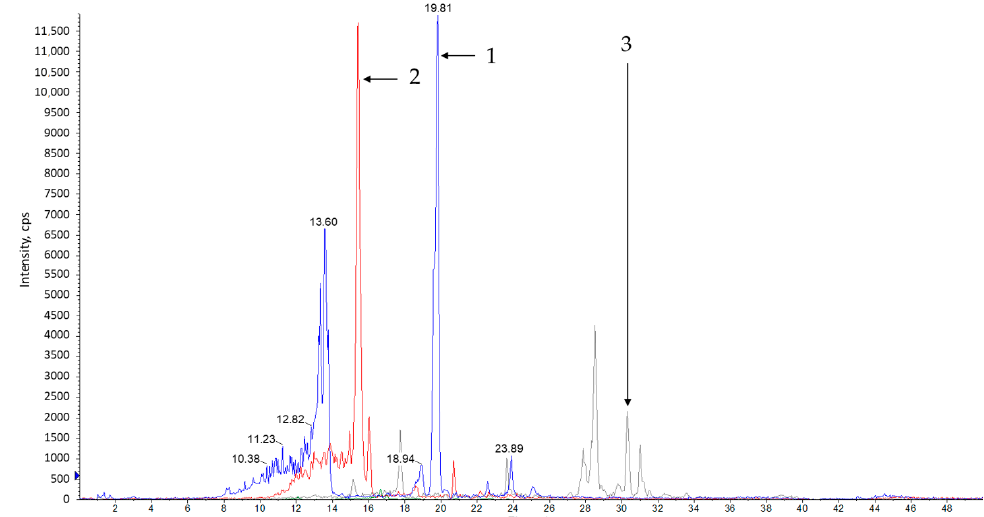
Figure 3. Example of a TIC chromatogram for extract of salvia leaves dried naturally. The chromatogram was obtained for the maximum absorbing wavelength at each time point; (1) p - coumaric acid (m/z = 162.8/119.1) and its derivatives; (2) ferulic acid (m/z = 192.8/134.0); (3) catechin (m/z = 289.0/289.0) and its derivatives.